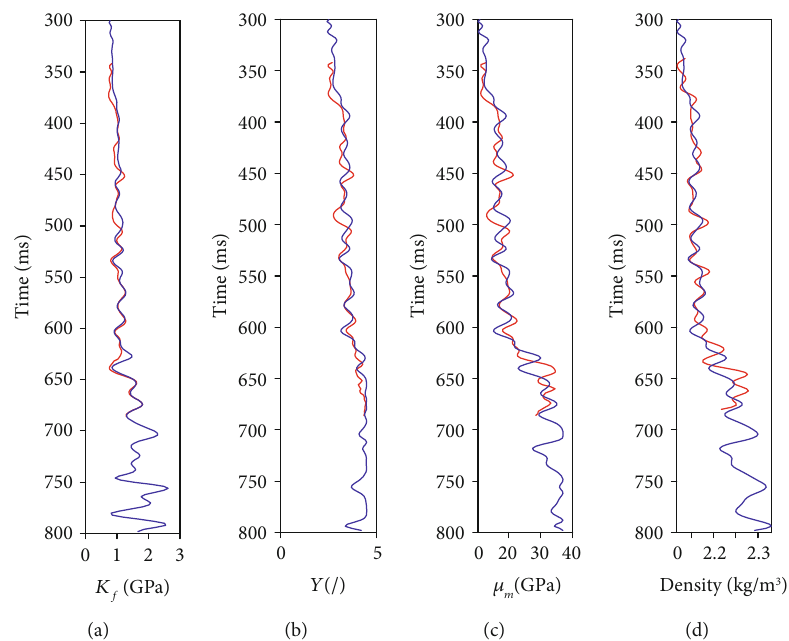
Y , (c) μ f , (b) m , and (d) density.